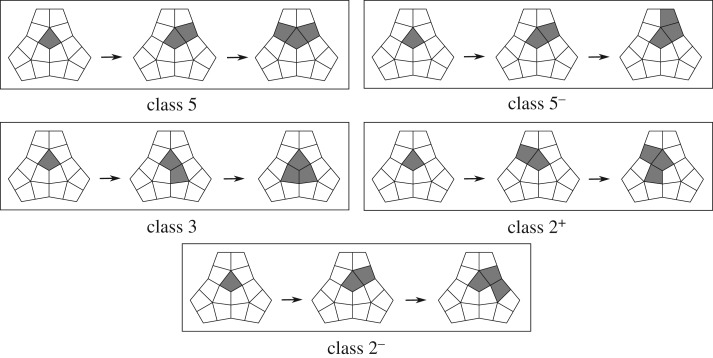
Classes of transition pathways. Different transition pathways are classified according to the positions of the second and the third protomer undergoing an opening event.